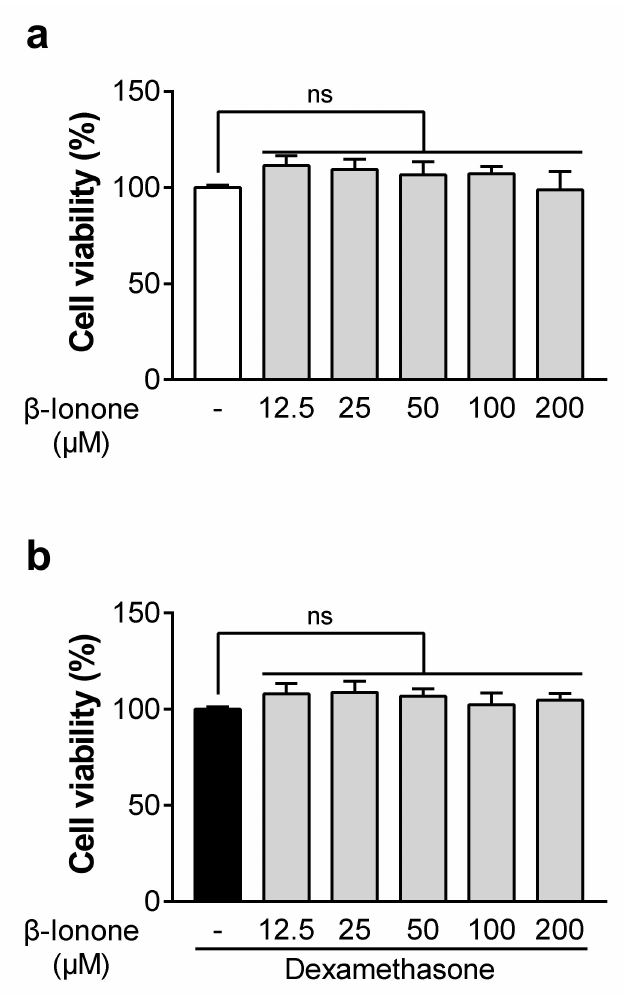
Figure 1. ( a , b ) Effects of β -ionone on the viability of dexamethasone-untreated and dexamethasone- treated human dermal fibroblasts. The cells were treated for 72 h with either vehicle (dimethyl sulfoxide (DMSO); shown as “-“) or different doses of β -ionone (12.5, 25, 50, 100, or 200 µ M) with or without dexamethasone (1 µ M). Cell viability was assessed by the WST-1 assay. Values are shown as mean ± standard error of the mean (SEM) of three